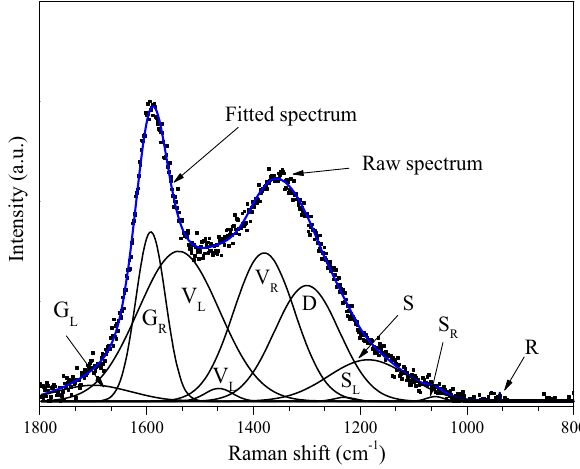
Fig. 2 Curve-fitting of the peaks in Raman spectrum of the char produced under H